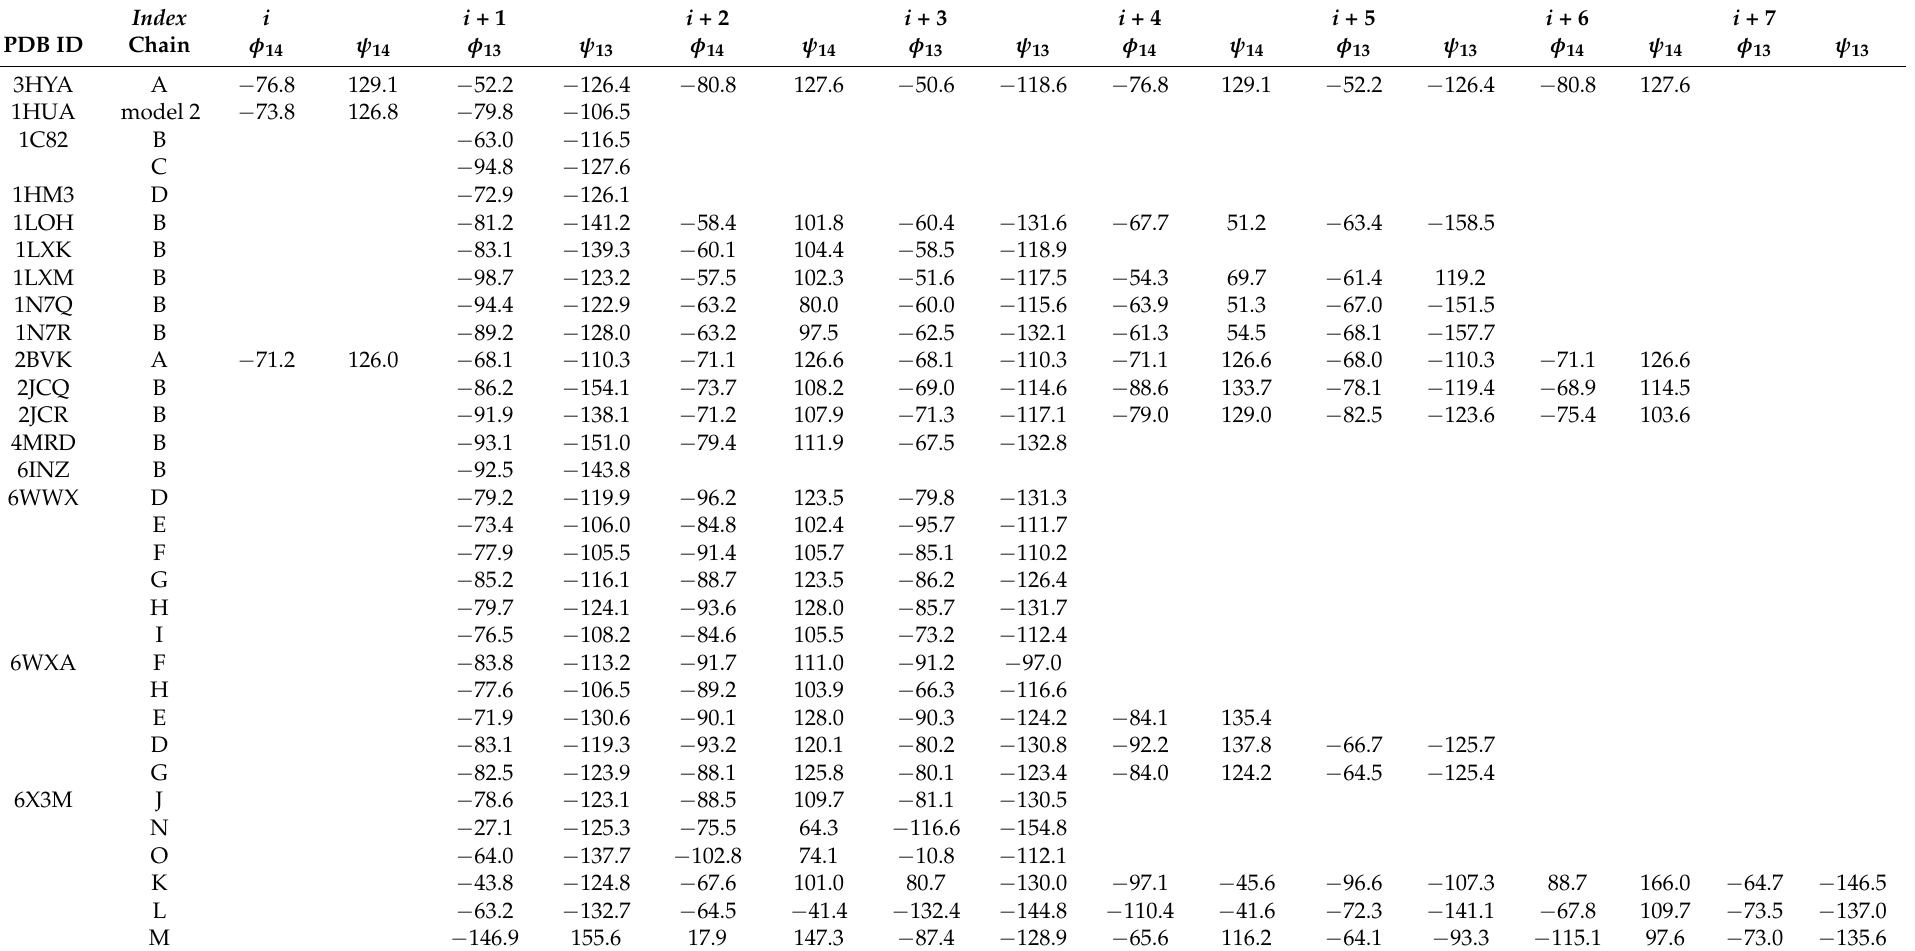
Table 2. Hyaluronan ( φ 14 , ψ 14 ) and ( φ 13 , ψ 13 ) dihedral angle values from PDB entries 1